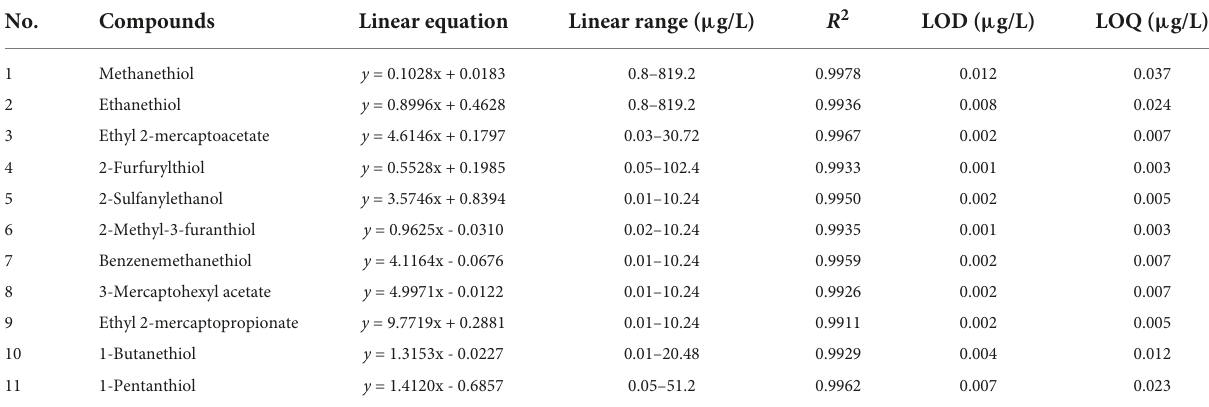
TABLE 2 Linear range, correlation coefficient ( R 2 ), limits of detection (LOD), and limits of quantitation (LOQ) of the established method for derivatized thiols.